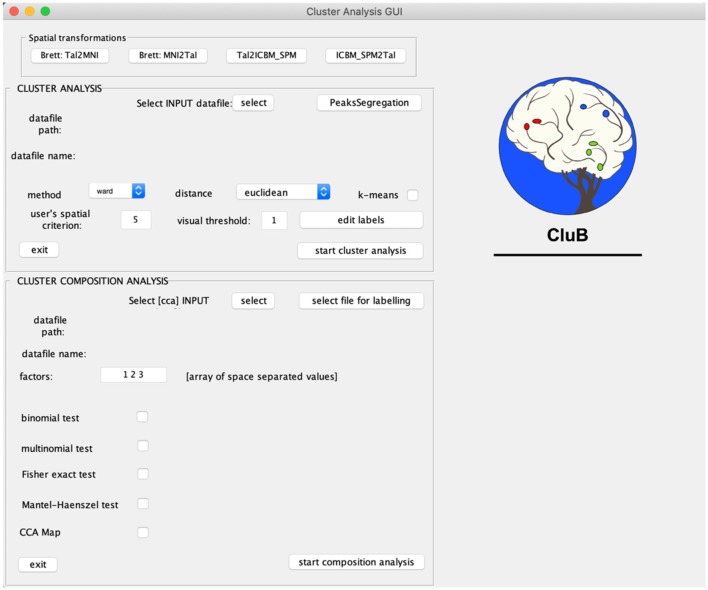
Graphical User Interface (GUI) of the CluB toolbox. Refer to section Introduction of the main text for a more detailed description of the toolbox.